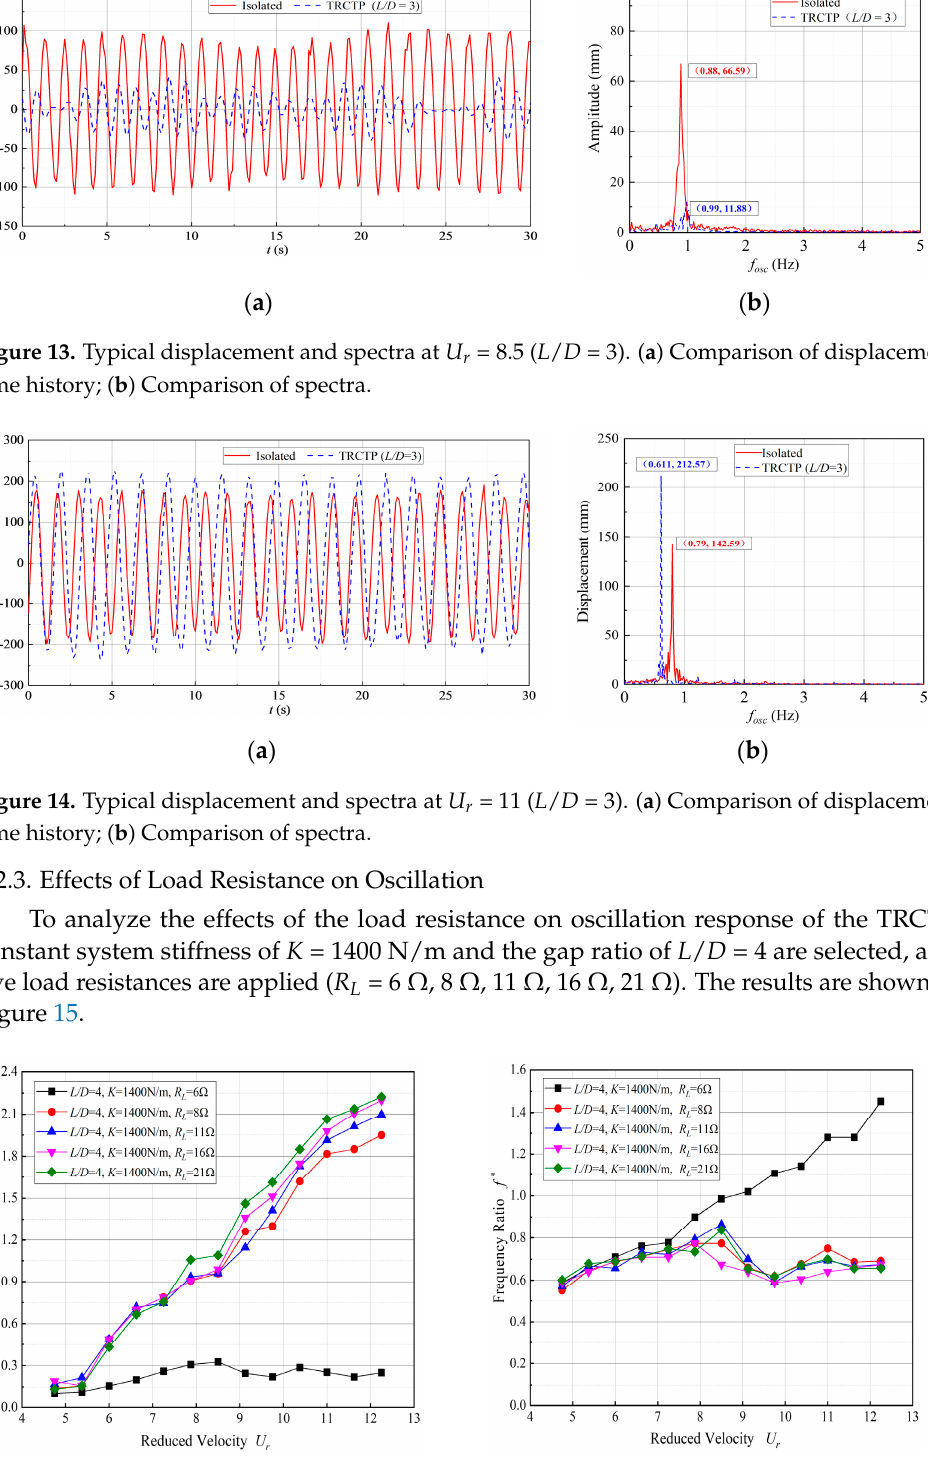
( b ) Figure 16. Typical displacement and spectra at U r = 11 ( L / D = 4). ( a ) Comparison of displacement time history; ( b ) Comparison of spectra. 3.3. Energy Conversion Analysis Considering that the “sharp jump” phenomenon may appear at L / D = 2 and L / D = 3 for the TRCTP, which can cause negative effects on energy conversion of the system, and the oscillation frequency is rather lower at L / D = 1, therefore, L / D = 1.5 and L / D = 4 are selected for the energy conversion tests in this section. Five different stiffness ( K = 1200 N/m, 1400 N/m, 1600 N/m, 1800 N/m, 2000 N/m) and five load resistances ( R L = 6 Ω , 8 Ω , 11 Ω , 16 Ω , 21 Ω ) were selected to discuss the effects of parameters on the energy conver- sion characteristics of the TRCTP. 3.3.1. Energy Conversion Analysis for L / D = 1.5 For 4.75 ≤ U r ≤ 6.625, the amplitude of the TRCTP is lower and the corresponding active power is small, and the energy conversion efficiency is lower than 0.4%. In the re- duced velocity range of 6.625 ≤ U r ≤ 9.75, the active power increases gradually with the growth of reduced velocity. In this case, the larger the load resistance is, the higher the active power will be, and the active power at a large stiffness is slightly higher. The max- imum active power is P harn = 3.27 W, which appears at R L = 21 Ω ( K = 2000 N/m, U r = 9.75), as shown in Figure 17.